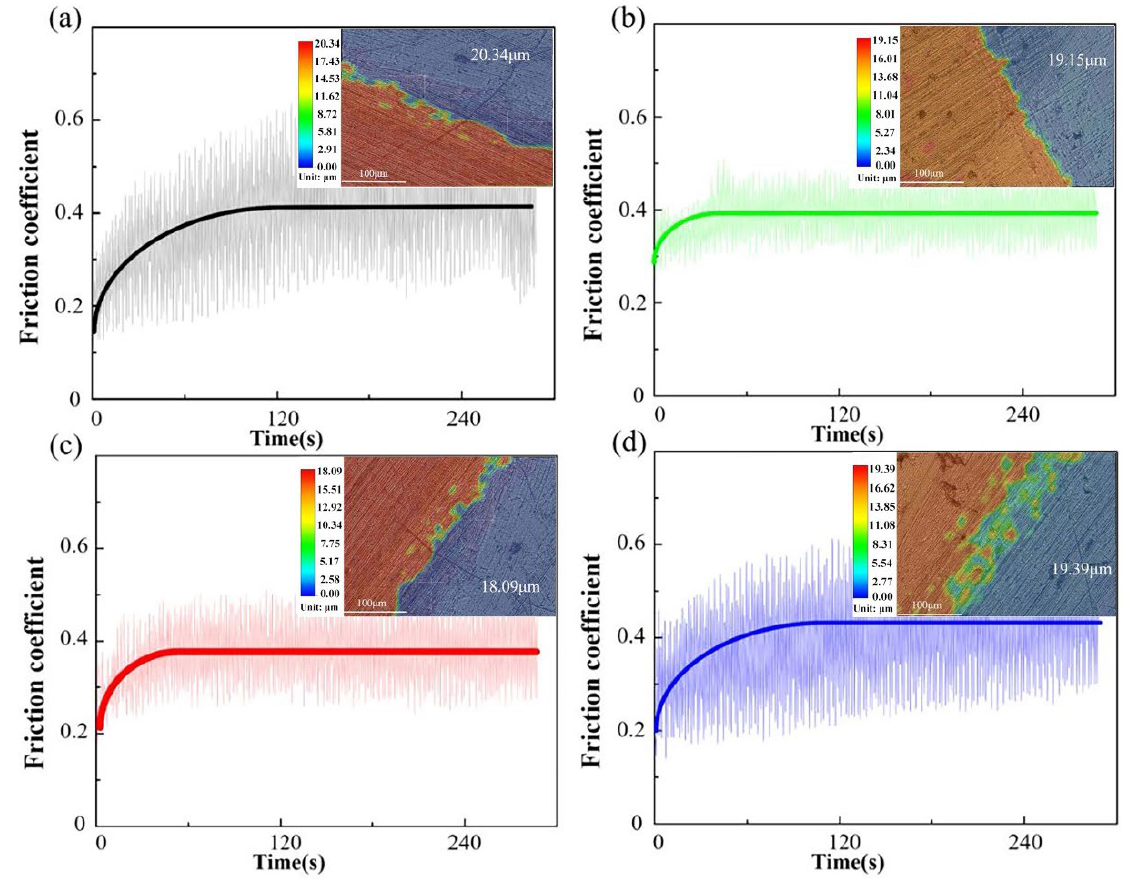
Figure 4. Coefficient of friction and wear rate: ( a ) PEEK, ( b ) 1.0 wt.%, ( c ) 3.0 wt.%, and ( d ) 5.0 wt.%.